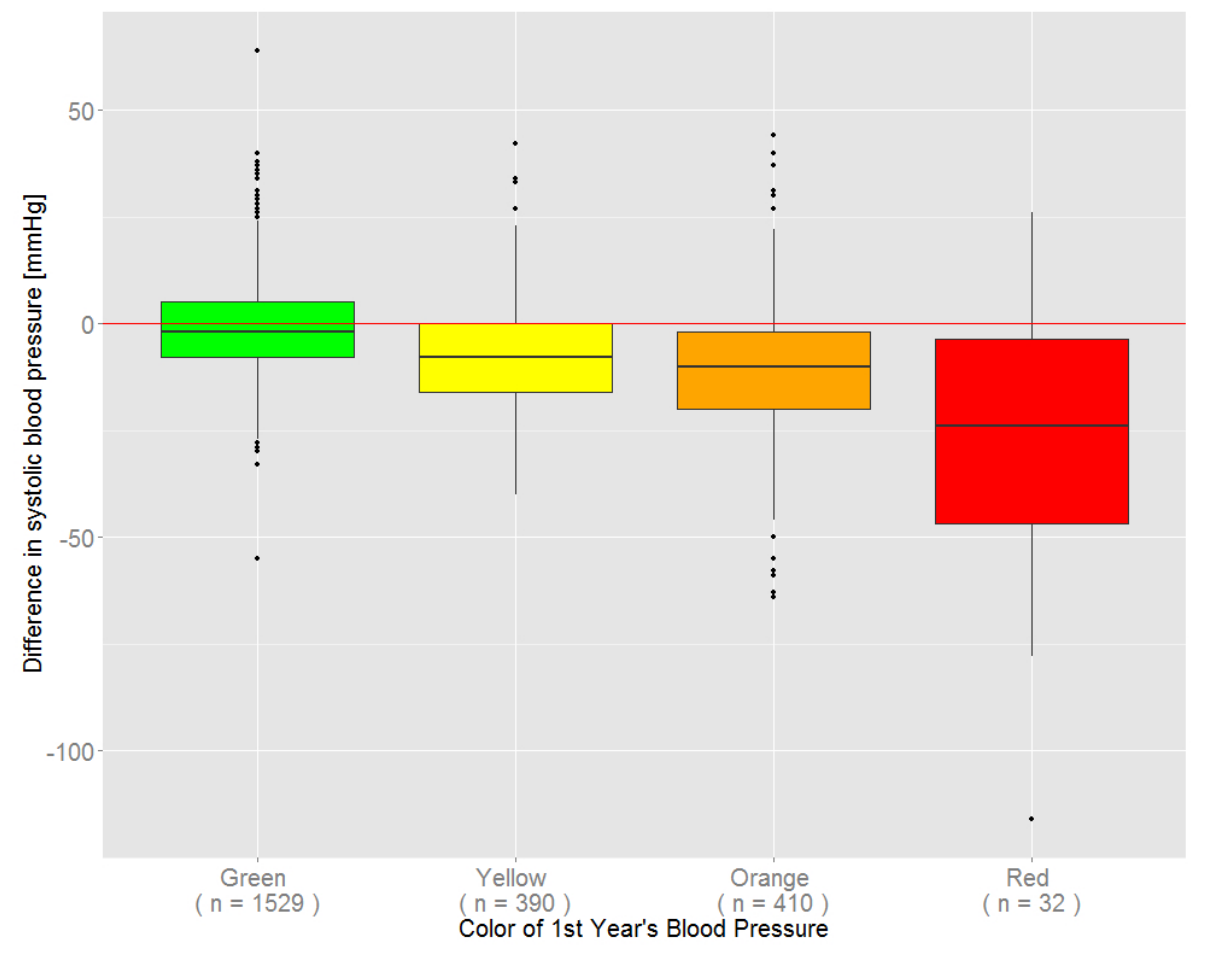
Figure 9. Difference in systolic blood pressure based on color ranking at the first checkup.